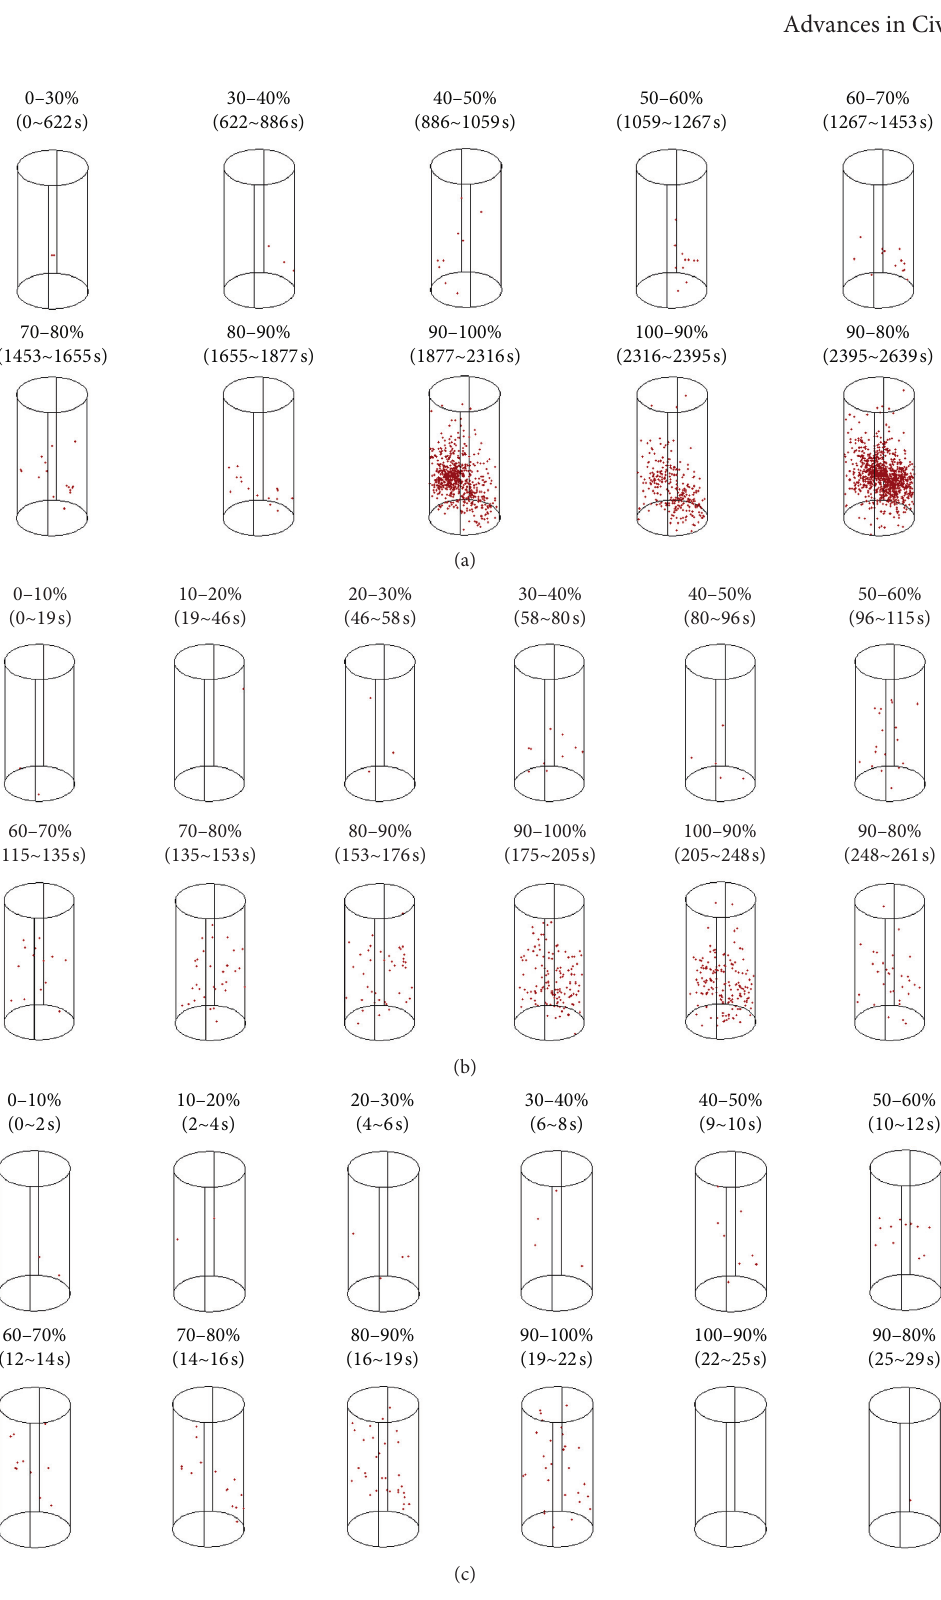
Figure 4: AE spatial distribution at different strain rates. (a) _ ε � 10 − 5 s − 1 . (b) _ ε � 10 − 4 s − 1 . (c) _ ε � 10 − 3 s − 1